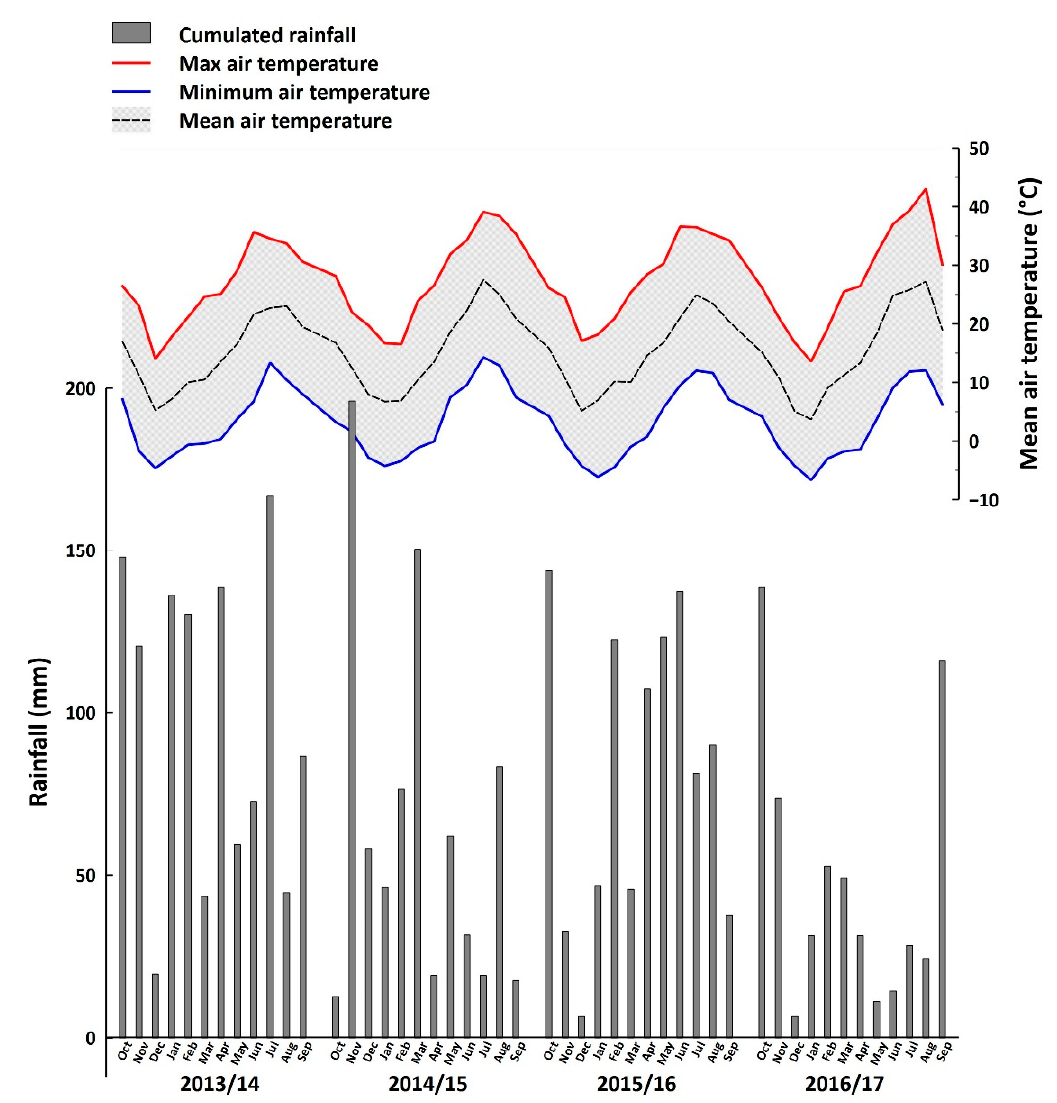
Figure 1. Monthly rainfall (mm) and mean, max and minimum air temperature values recorded at the experimental field station ‘FieldLab’ (Papiano, Perugia, Italy) during the 4-year experiment.